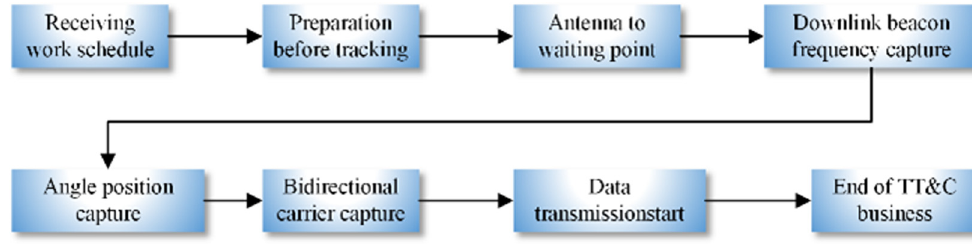
Figure 9: The capture and track process of planned access